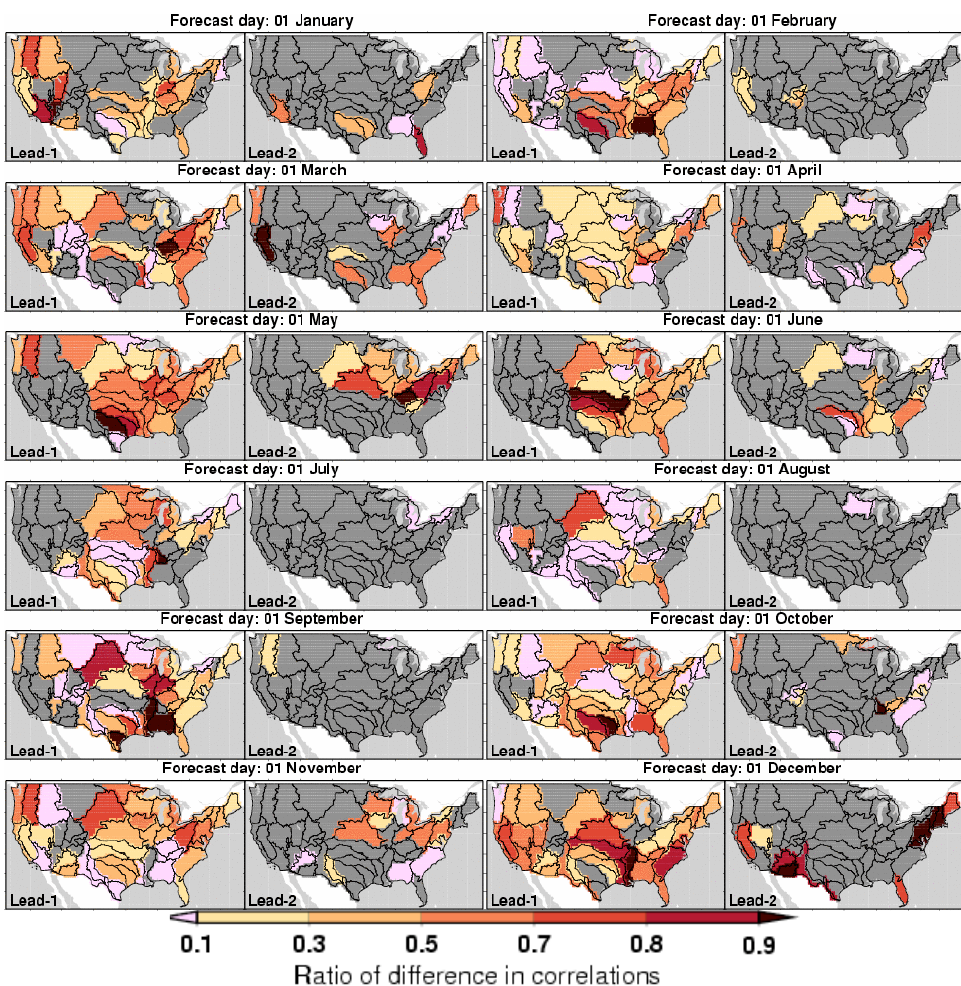
Figure 6: The ratio of actual improvement and potential improvement in baseline runoff 3 Fig. 6. The ratio of actual improvement and potential improvement in baseline runoff forecast skill at leads 1–2 months (dark grey color shows the sub-regions where either the potential improvement in skill is < 0.1 or the skill of OBS Merged ESP is not significant at the 95% forecast skill at leads 1-2 months. (Dark grey color shows the sub-regions where either 4 significance the potential improvement in skill is < 0.1 or the skill of OBS_Merged_ESP is not 5 significant at 95% significance level.) 6